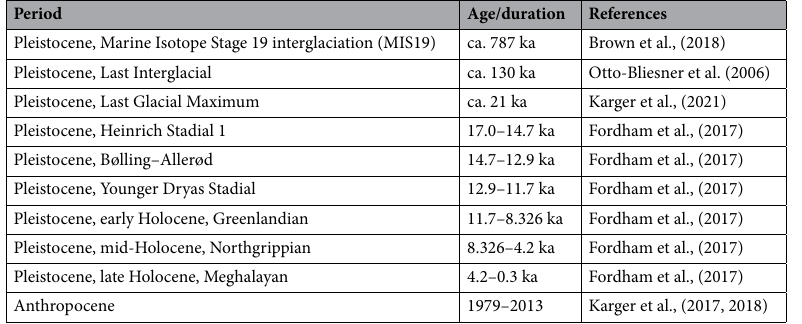
Table 2. Sets of variables used for